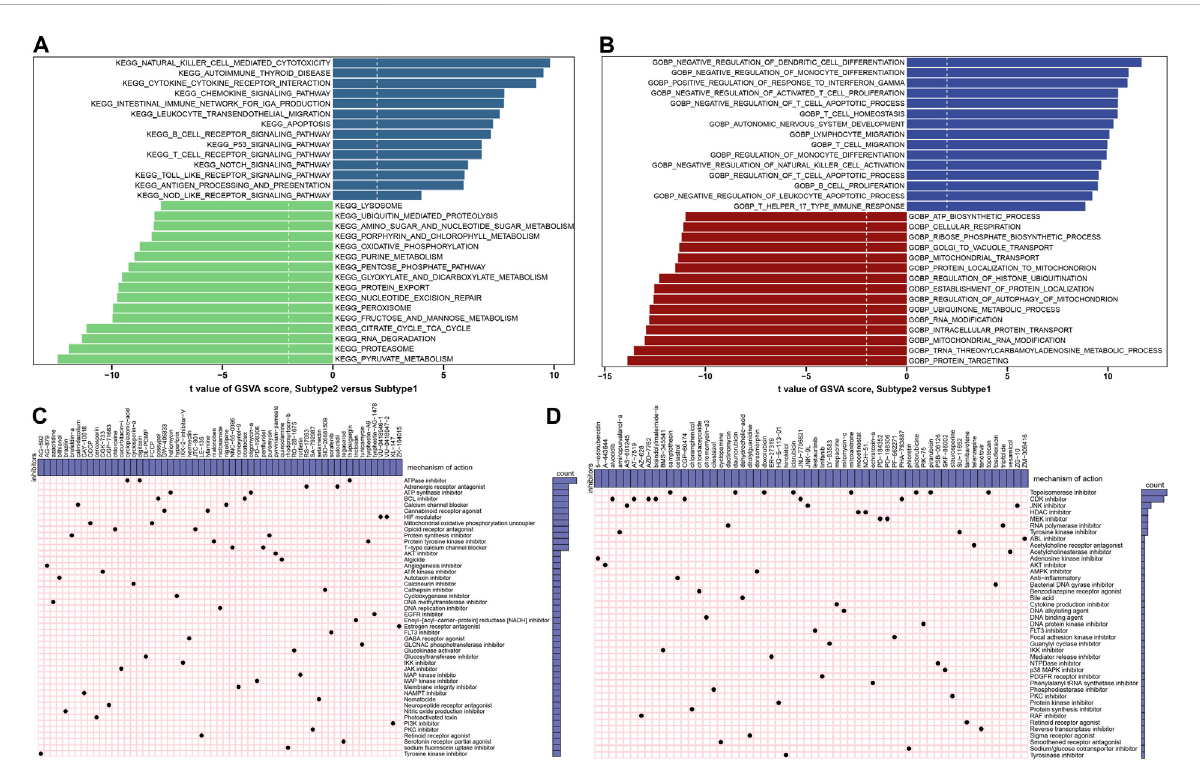
FIGURE 11 Identi fi cation of cluster-speci fi c biological characteristic and small-molecule compounds. (A) Differences in the enriched hallmark pathways between ER stresssubtypes ranked by tvalueof GSVAscore. (B) Differences inenriched biologicalfunctionsbetweenERstress subtypes ranked byt value of GSVA score. (C,D) CMap analysis shows the MoA based on subtype1-speci fi c (C) and subtype2-speci fi c (D) small-molecule